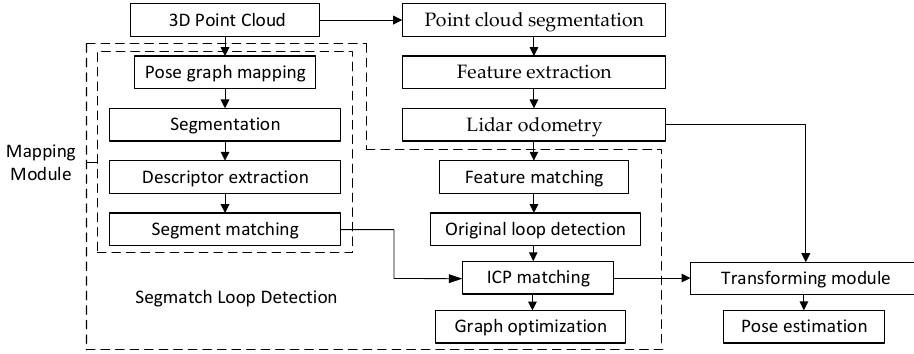
Figure 1. Block diagram of the LeGO-LOAM-SM algorithm.